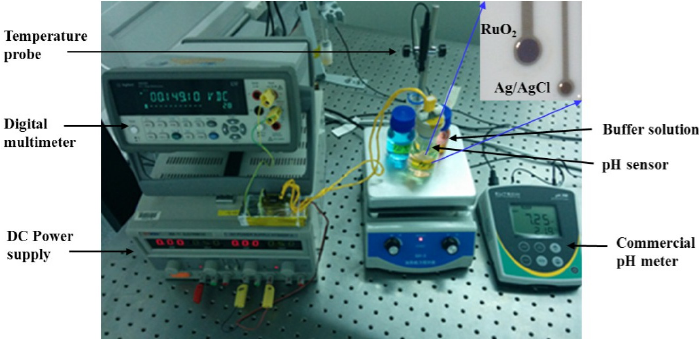
Figure 1. Microphotograph of the pH measurement